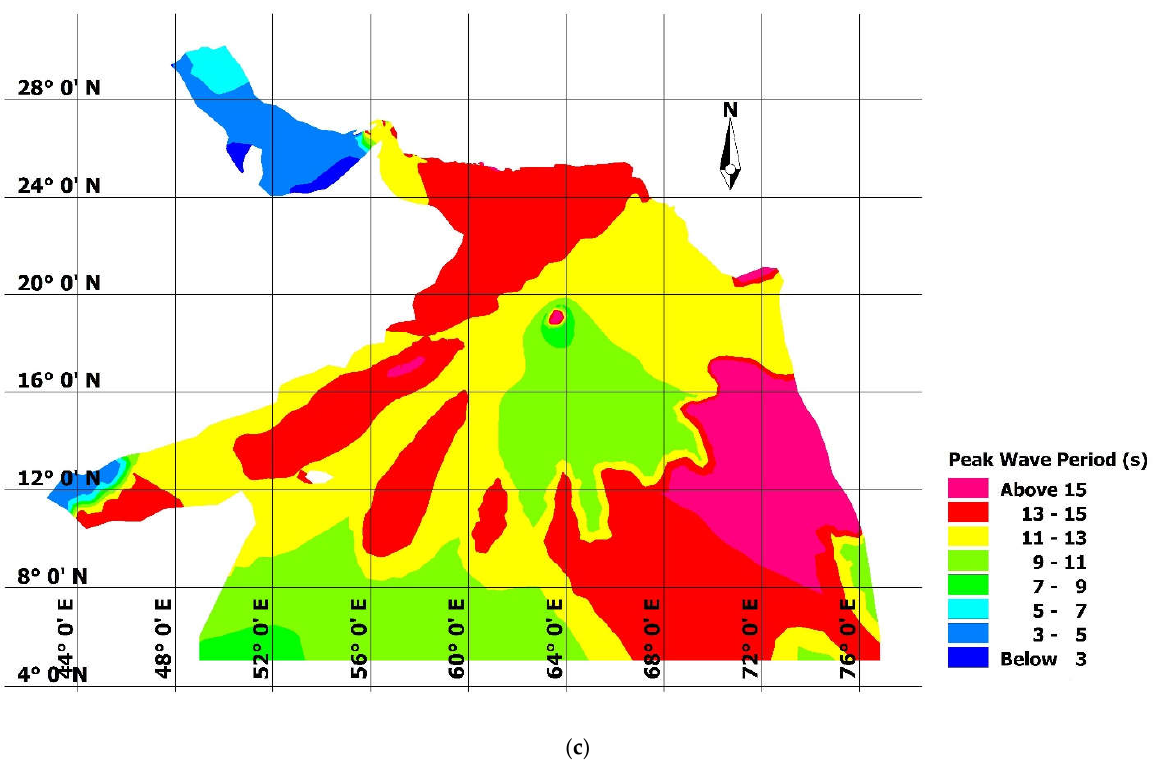
Figure 11. Wave parameters pattern in the computational domain ( a ) significant wave height, ( b ) maximum wave height, and ( c ) peak wave period.